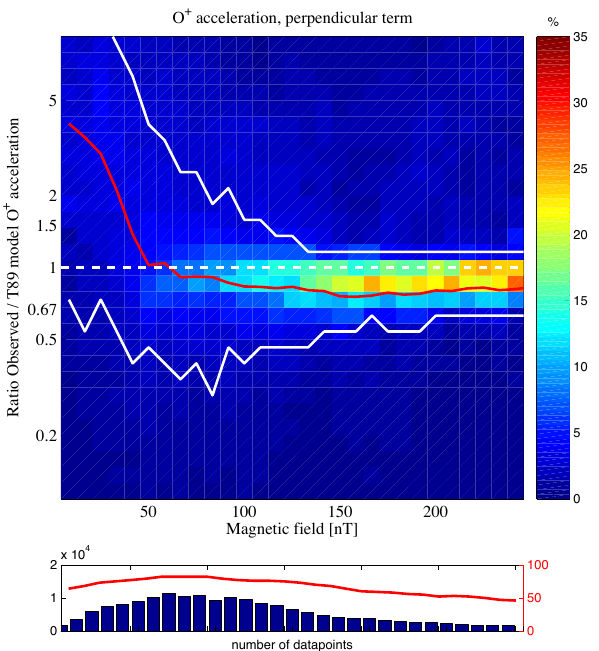
Fig. 7. Upper panel: Distribution of the ratio of the parallel term of the centrifugal acceleration of O + (positive in direction of outflow) from observed magnetic field values and with magnetic field values from the Tsyganenko 89 model, for each interval of magnetic field strength [nT]. Each column is normalized, the sum of all data bins in a column is 100% if all data points are contained in the plotted region. White lines indicate the narrowest region around the maximum in each column which contains 50% of all data points. A red line shows the median value of the parallel velocity ratio for each magnetic field interval. Lower panel: Number of data points contributing to each column (blue bars, left y-axis), and the number of measurement days contributing to the column (red line, right y-axis).